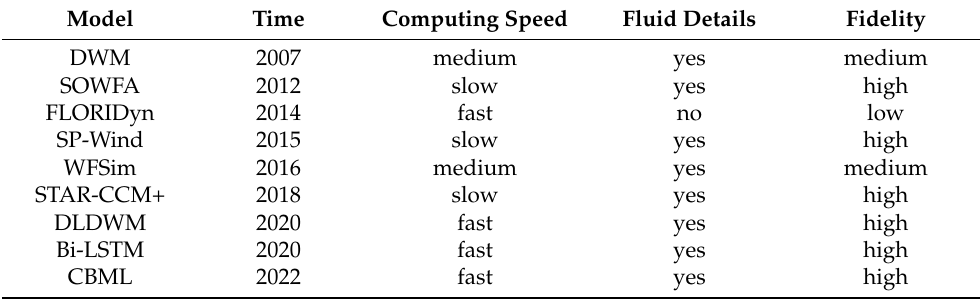
Table 1. Dynamic wake model